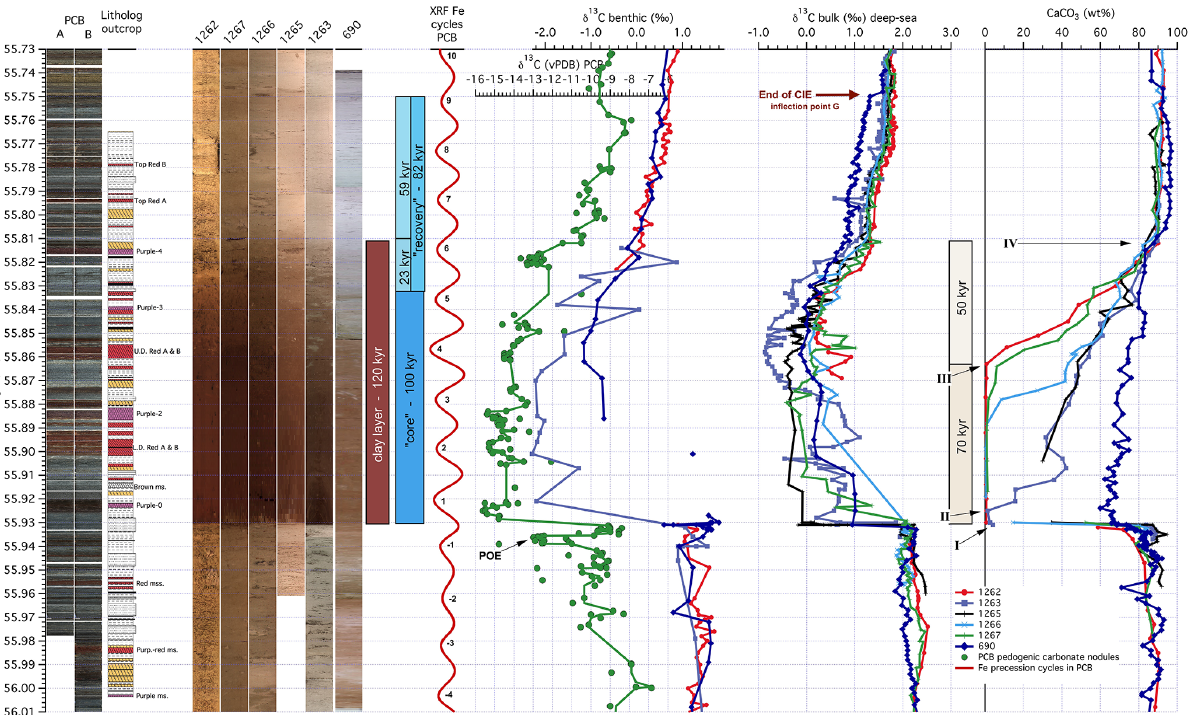
Figure 7. Overview for the Paleocene–Eocene Thermal Maximum (PETM) data from deep-sea records and the terrestrial Polecat Bench (PCB) drill core against age. Core images and lithology log (Gingerich, 2006) for PCB, core images of ODP Sites 1262, 1267, 1266, 1265, 1263, and 690 (aligned from left to right according to the water depth from deep to shallow), defined phases of events in the PETM (Röhl et al., 2007) on the new age model, extracted precession cycles using a Gaussian filter of the PCB XRF Fe intensity data, stable carbon isotope data from PCB soil nodules (Bowen et al., 2015), the deep-sea benthic foraminifera and bulk sediment (690 – Bains et al., 1999; Leg 208 – Zachos et al., 2005), and carbonate content (690 – Farley and Eltgroth, 2003; Leg 208 – Zachos et al., 2005). Letters indicate horizons as identified by Zachos et al. (2005) adjusted to the new age model for the deep-sea